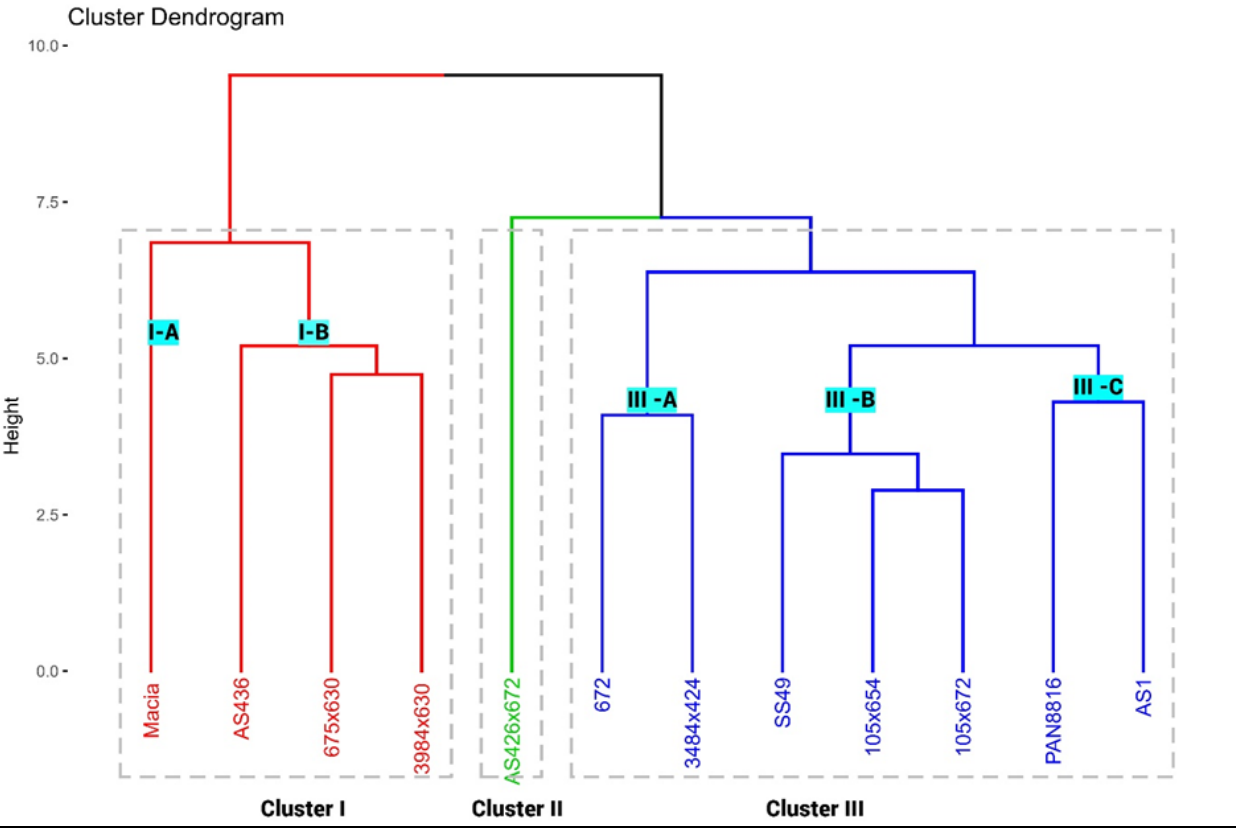
Figure 1. Dendrogram showing diversity among the sorghum genotypes generated using agronomic traits and nutritional qualities based on UPMA. (The different colors show clustering groups between the genotypes). Table 4. Principal components (PC) for agronomic traits and nutritional compositions among 12 elite sorghum